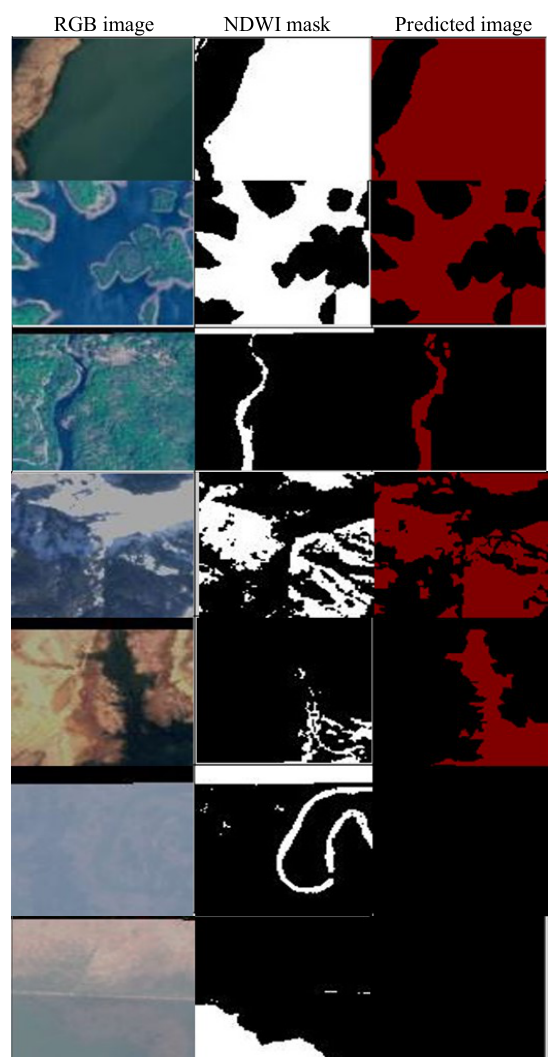
Figure 3. Select input RGB (left), corresponding NDWI derived mask (middle), and the trained DeepLabV3+ model predicted (right) masks. The Jaccard scores for the 7 sample images (top to bottom) were 0.8436, 0.9141, 0.7526, 0.4169, 0.3658, 0 and 0 respectively. The corresponding Dice scores were 0.8924, 0.9732, 0.8025, 0.5472, 0.4198, 0 and 0 respectively. From the sample images presented in Figure 3, it is evident that the DepLabV3+ model was able to correctly predict water (target) class under certain conditions. Irrespective of the number of target pixels (occupancy) in an image, the model correctly identified most of the target pixels in rows 1-3. These images were of good quality, and the water bodies were also relatively clear in